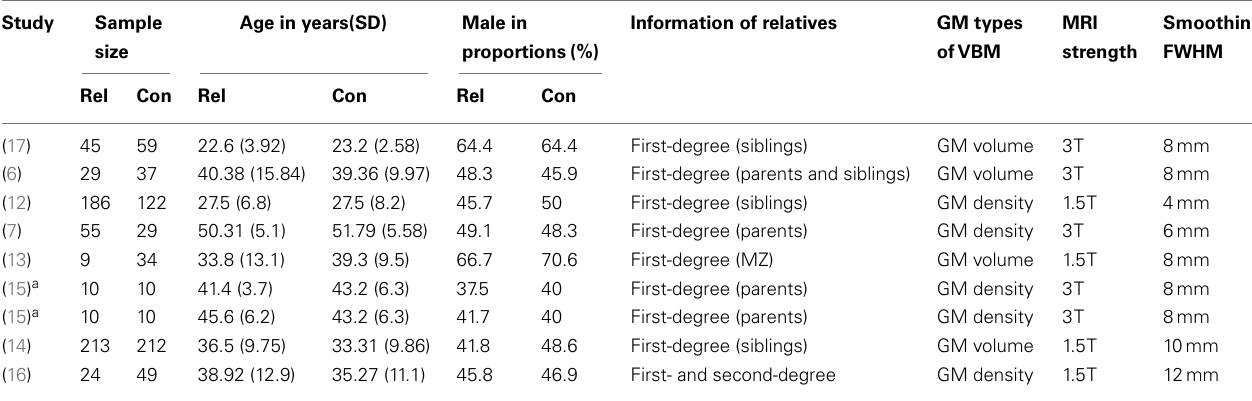
Table 2 | Demographic characteristics of the studies comparing relatives of patients with schizophrenia and healthy controls